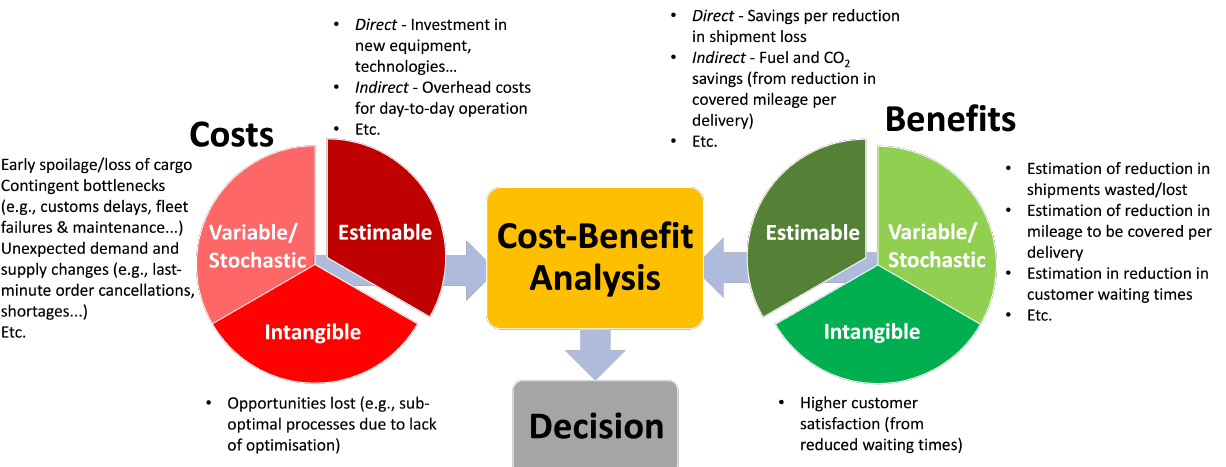
Figure 1. A figure showing the difficulties when considering the cost–benefit of digitalisation in